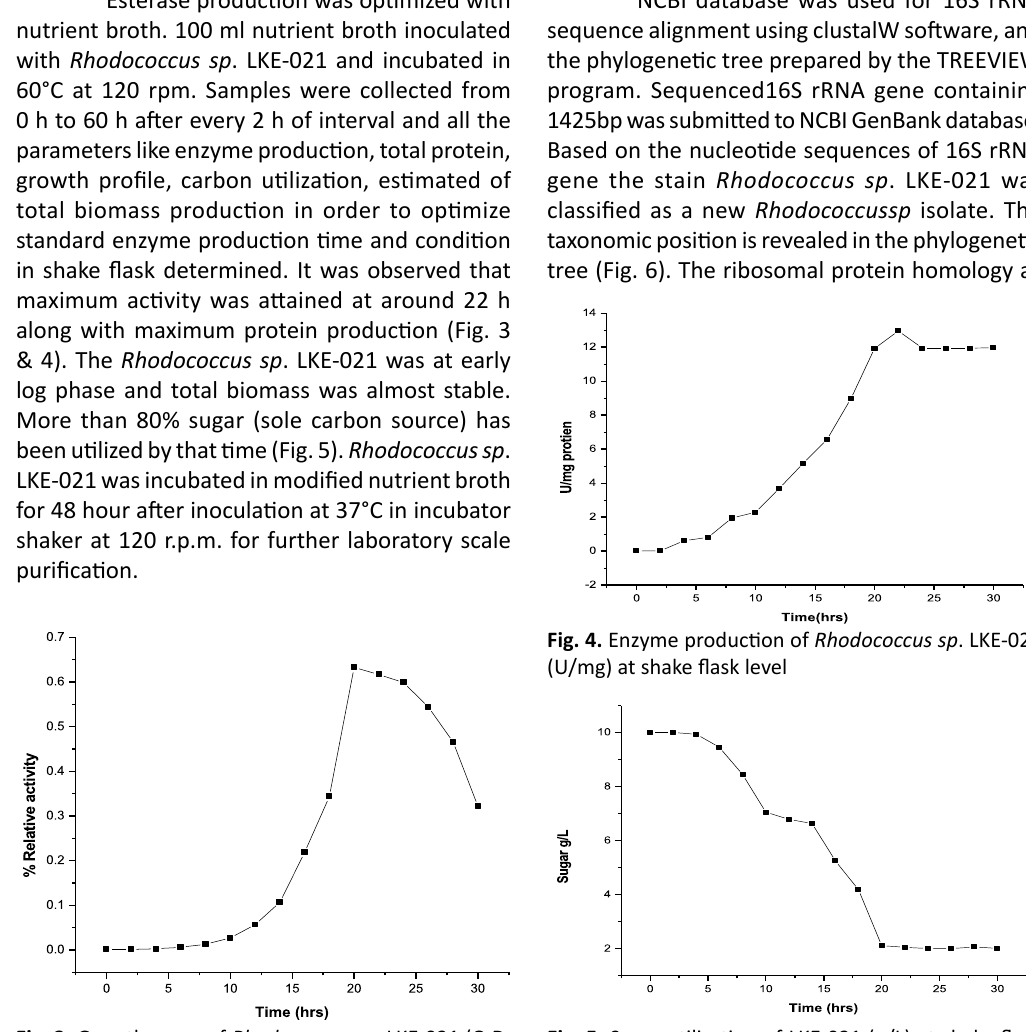
Fig. 5. Sugar utilization of LKE-021 (g/L) at shake flask